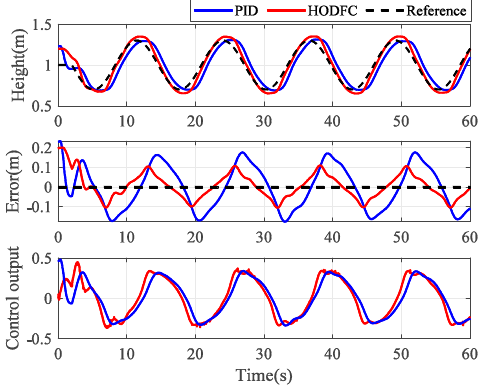
Figure 10. Experimental results of height with a sinusoidal function reference.